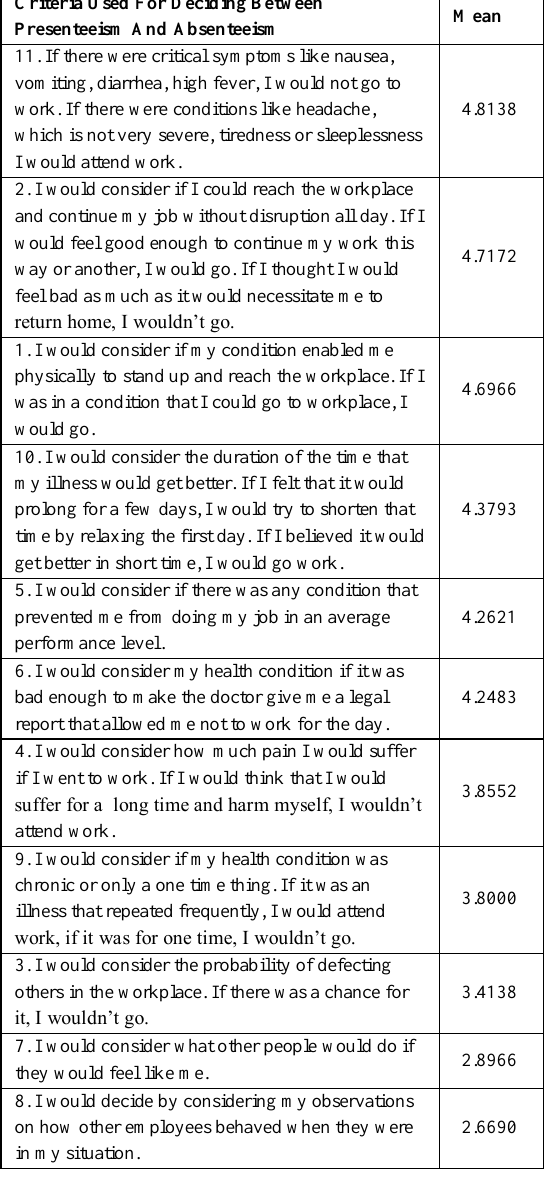
Table 13. Criteria Used For Deciding Between Presenteeism and Absenteeism and Their